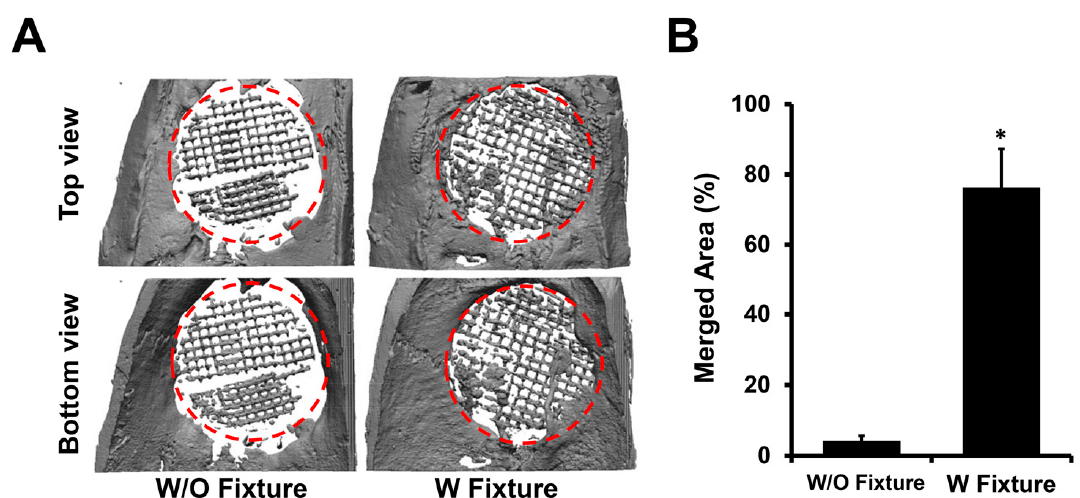
Figure 2. ( A ) Micro-CT image of calvarial defects after 12 weeks of scaffold implantation with and without Gelfoam ® and Ti mesh. ( B ) Merged area between host bone and scaffold in the defect site was quantified using Image J software ( n = 5, * p <0.05).